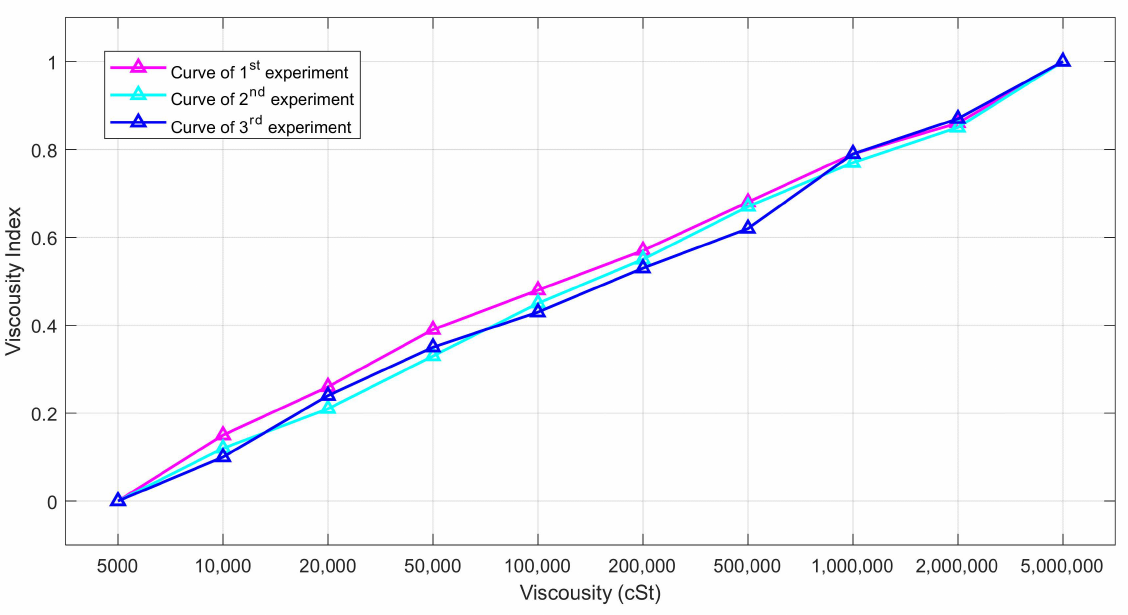
Figure 15. Normalized viscosity monitoring index for three replicated